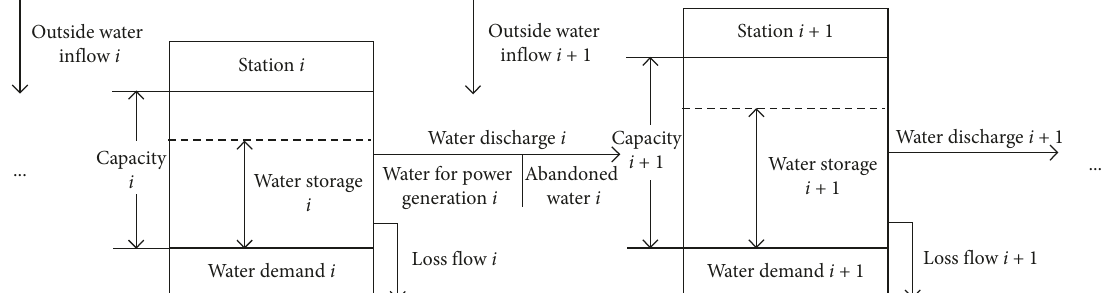
Figure 1: Illustration of operational